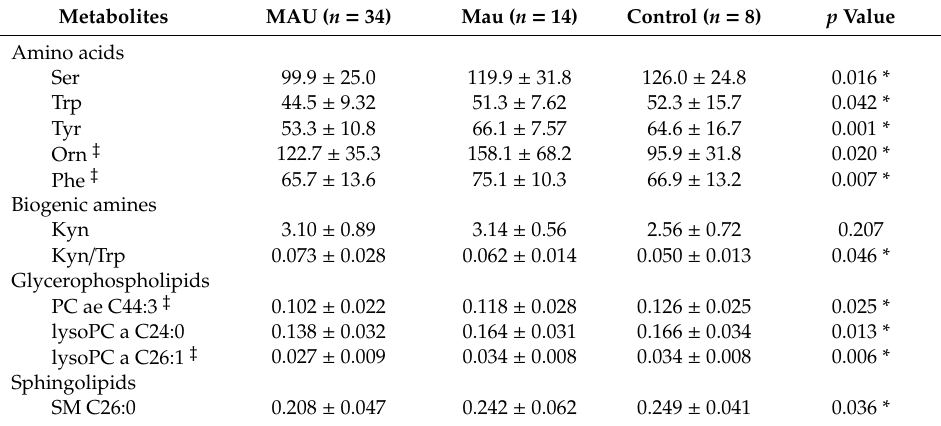
Table 2. Metabolites showed a significant association with various stages of albuminuria in 56 T2DM